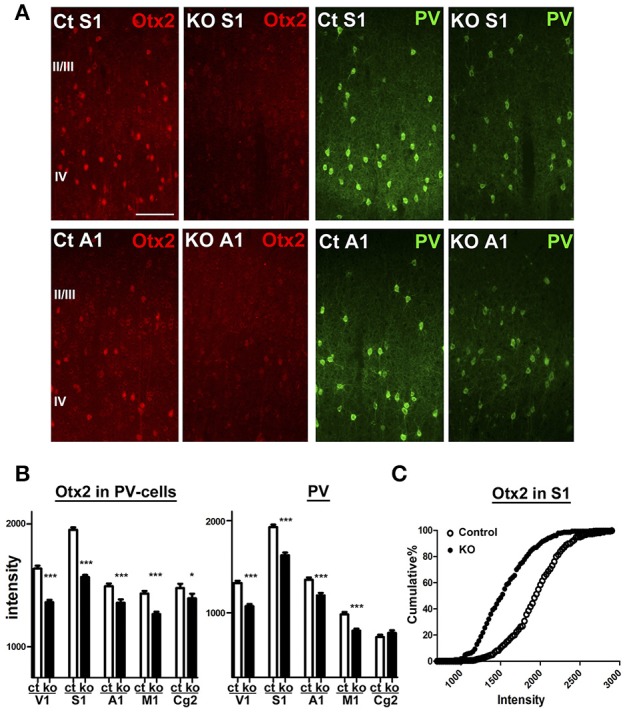
Otx2 reduction across cortical regions in conditional KO mice. (A) Reduction of Otx2 (red) and PV (green) immunoreactivities in the primary somatosensory (S1) and auditory (A1) areas in Otx2 KO mice at P28. The scale bar represents 100 μm. Ct, control. (B,C) Quantitative analysis of intensity for Otx2 and PV within PV-cell somata in supragranular layers of each cortical regions (Ct, control; M1, primary motor cortex; Cg2, cingulate area 2; control vs. KO, 171–339 cells for control, 178–321 cells for KO, n = 6, Mann–Whitney U-test, ***p < 0.0001; *p < 0.05). Cumulative distribution reveals decreased intensity of Otx2 in the S1 of Otx2 KO mice (C).